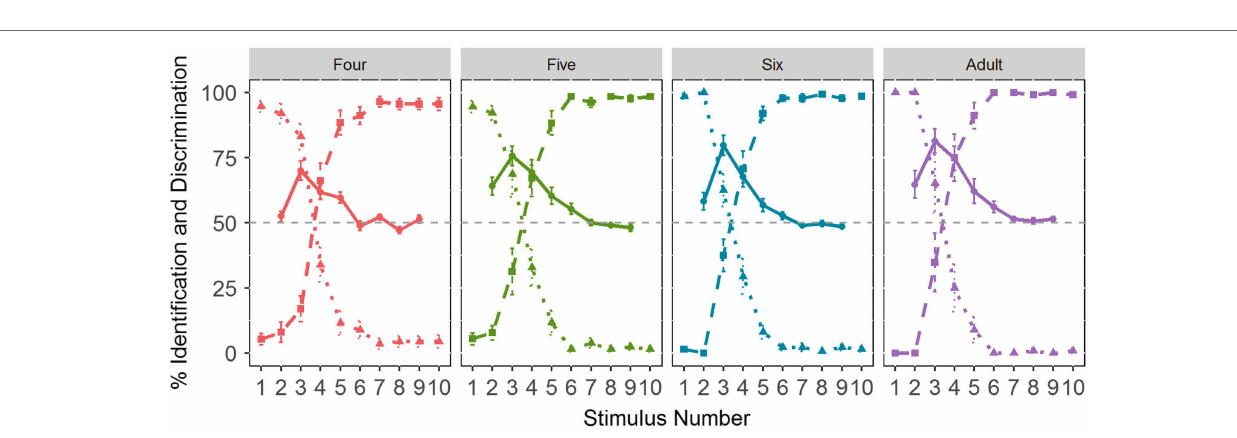
FIGURE 8 | The identification and discrimination curves of the VOT continuum across age groups. The dotted line represents /pa1/ responses. The dashed line indicates /p h a1/ responses. The solid line refers to discrimination